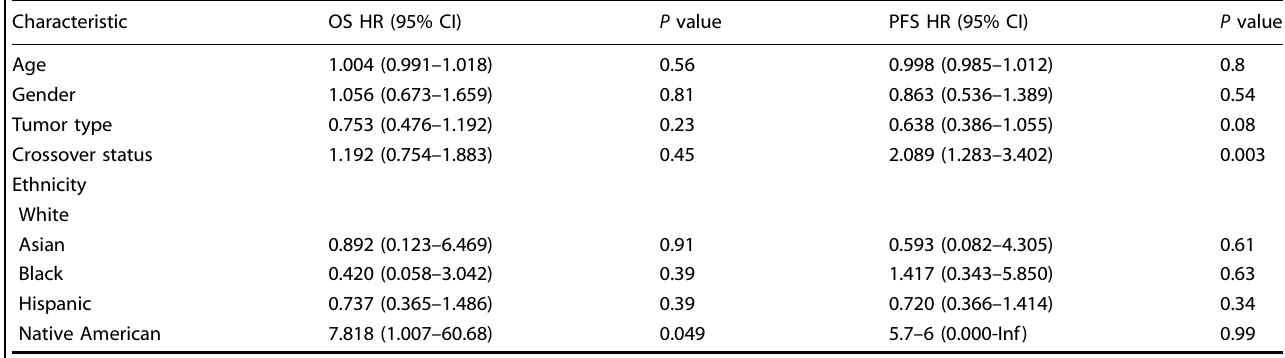
Table 4. Univariate analysis of patient characteristics and survival